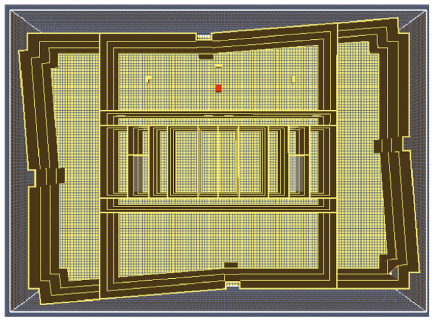
Figure 14: Structure of fire scenario